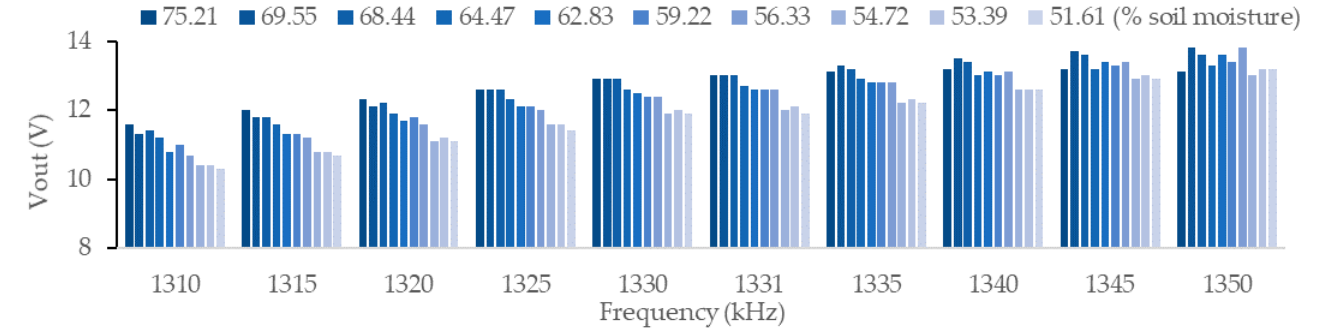
Figure 16. Vout of P9 using S1.